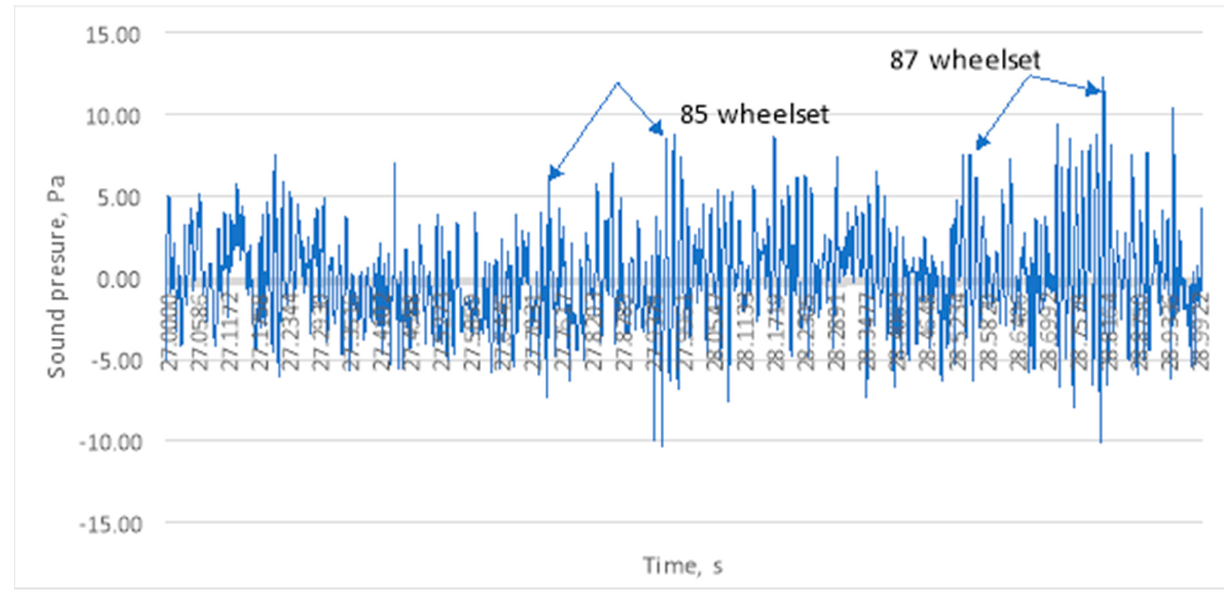
Figure 8. Sound pressure due to the 85th and 87th wheelset defects. Area 2 indicates the defect (Figure 6).